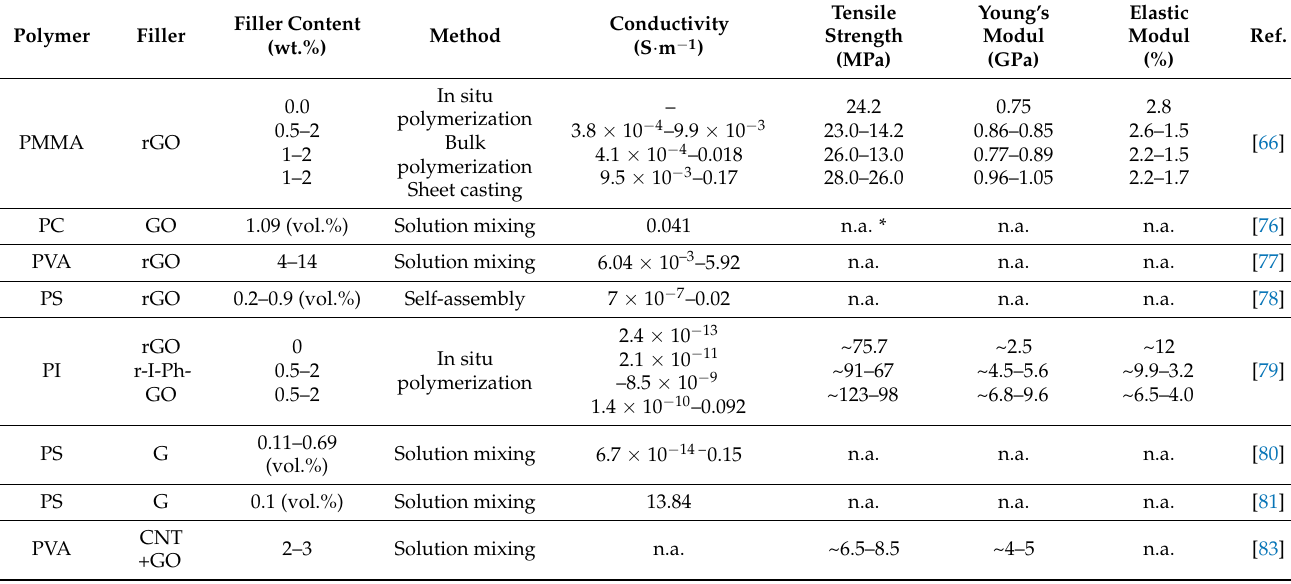
Table 1. Electrical conductivity and mechanical properties of G, GO, rGO/polymer nanocomposites. Filler Content Polymer Filler